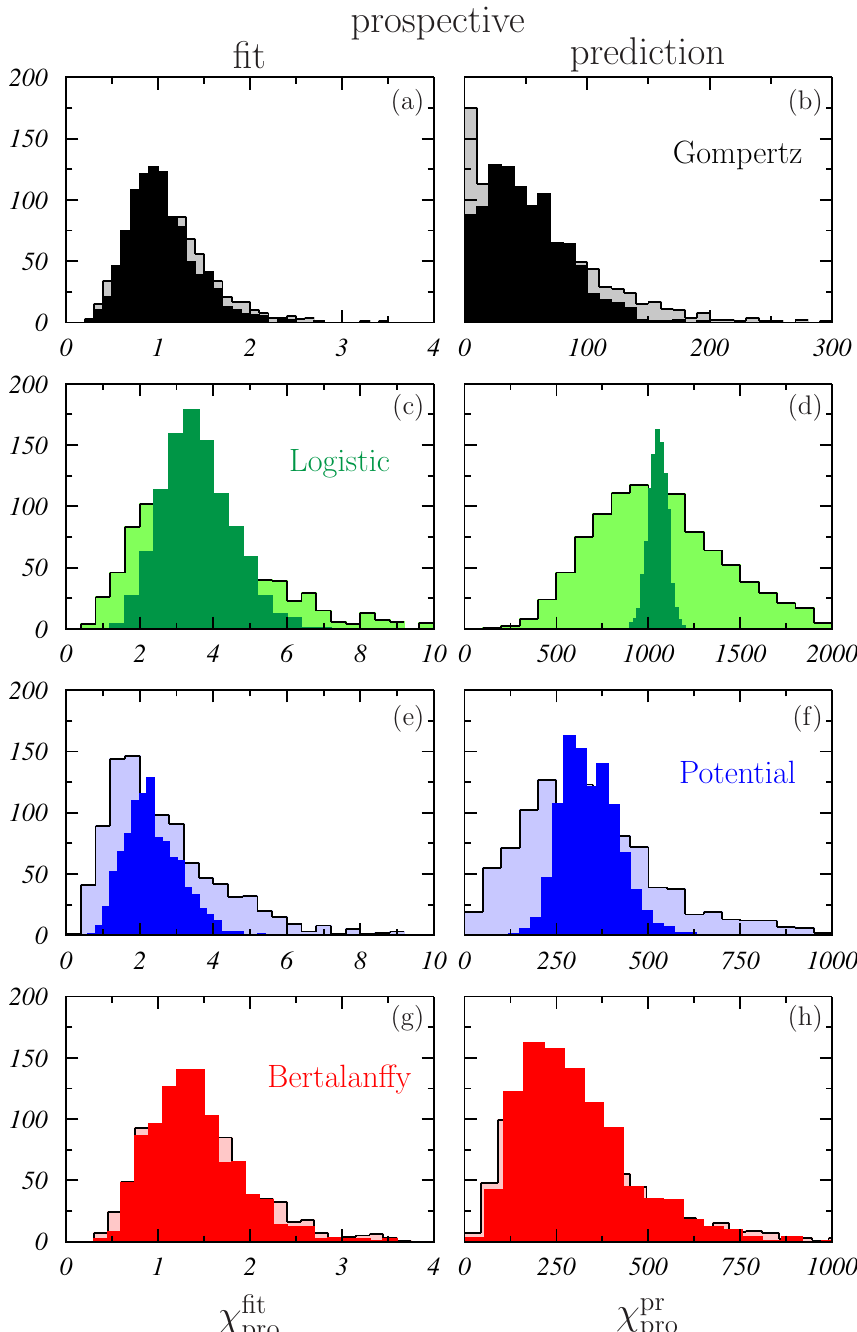
Figure 6. Distribution histograms of the values of χ pro obtained in the prospective fits of the four mathematical models considered to the simulated MTS in samples #1 (dark colors) and #2 (light colors).Left panels correspond to the fits to data in the time interval [20–40] day and right panels to the prospective fits to data in the time interval [41–60] day. The results obtained for the Gompertz ( a , b ), logistic ( c , d ), potential ( e , f ) and Bertalanffy ( g , h ) models are shown. To finish the analysis of the performance of the various mathematical models with regard to the description of the simulated MTS, the goodness of the fits when they are done in different regions of the growth curves was studied. Figure 7 shows the average values of χ reg and the corresponding 95% CI obtained for the four mathematical models as a function of the initial day of the data region fitted (which include 20 consecutive